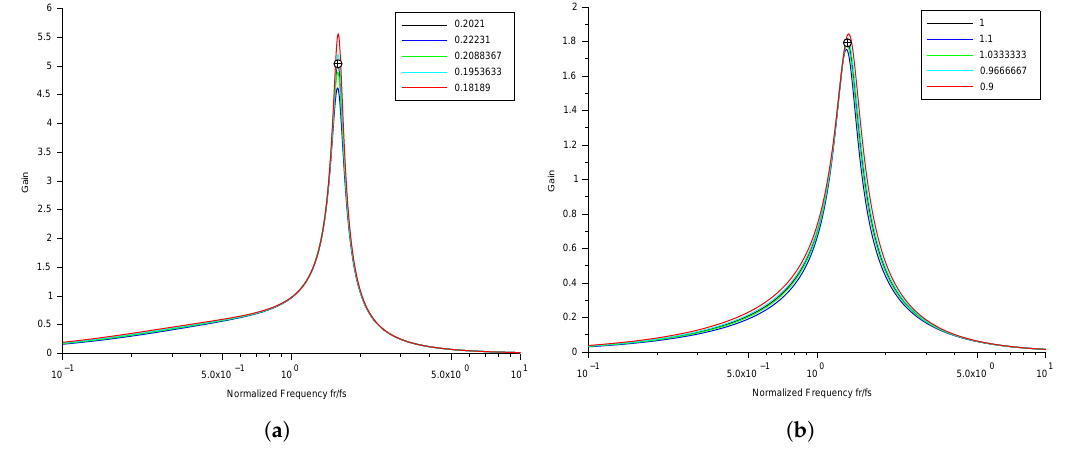
Figure 8. Gain of the resonant network: ( a ) With Q tank = 0.2; ( b ) With Q tank =